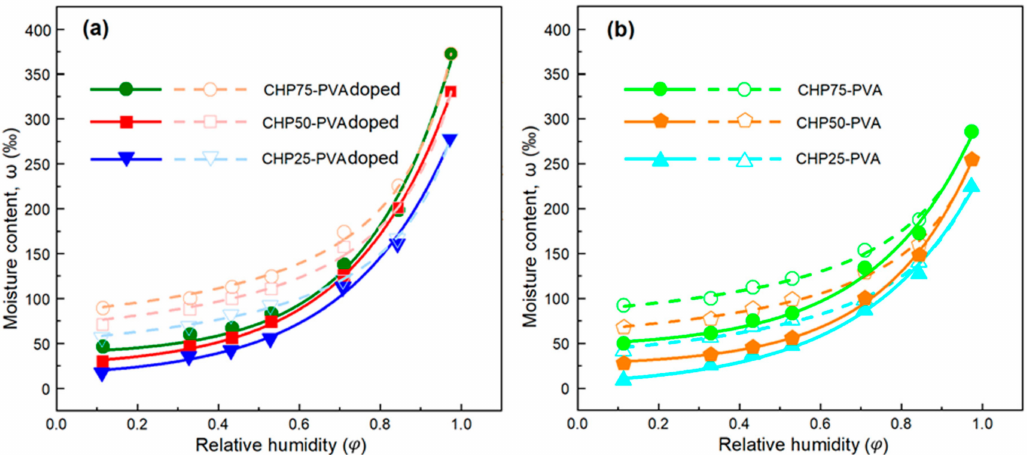
Figure 7. Isothermal moisture adsorption (solid line) and desorption (dotted line) properties of films versus relative humidity at room temperature: ( a ) for the acid-doped films; ( b ) for the base-neutralized